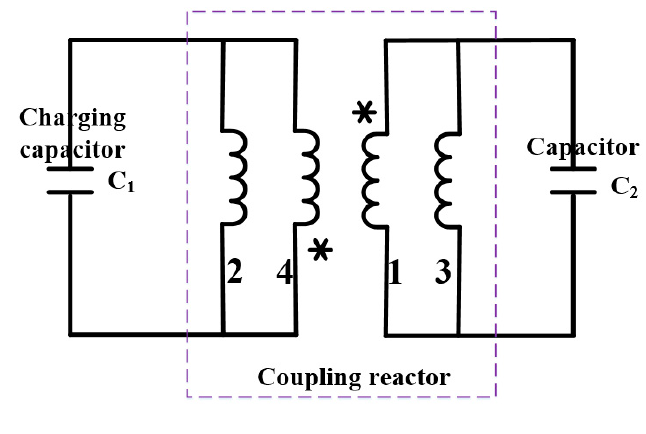
Figure 4. The circuit model.